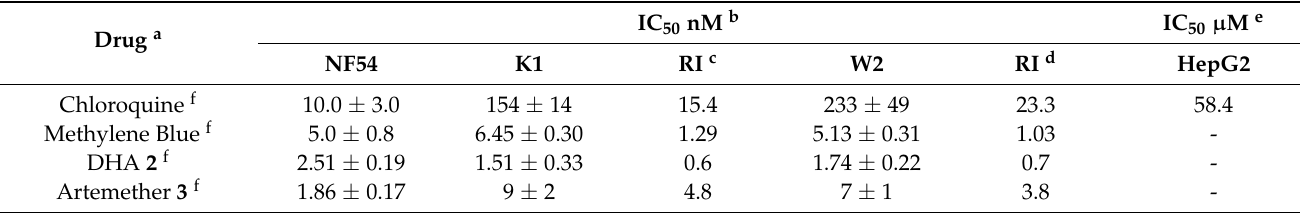
Table 1. Activities in vitro against chloroquine-sensitive and multidrug resistant asexual blood stage Pf parasites and cytotoxicities against HepG2 cells. Drug